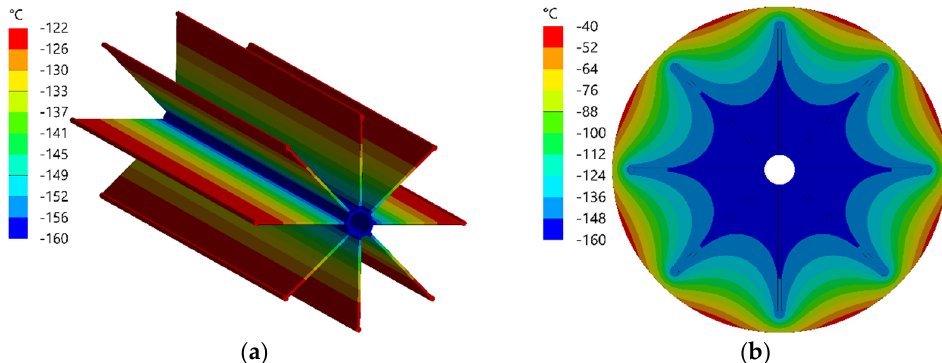
Figure 10. Temperature distribution: ( a ) 8 fins—no frost, ( b ) 8 fins with frost.